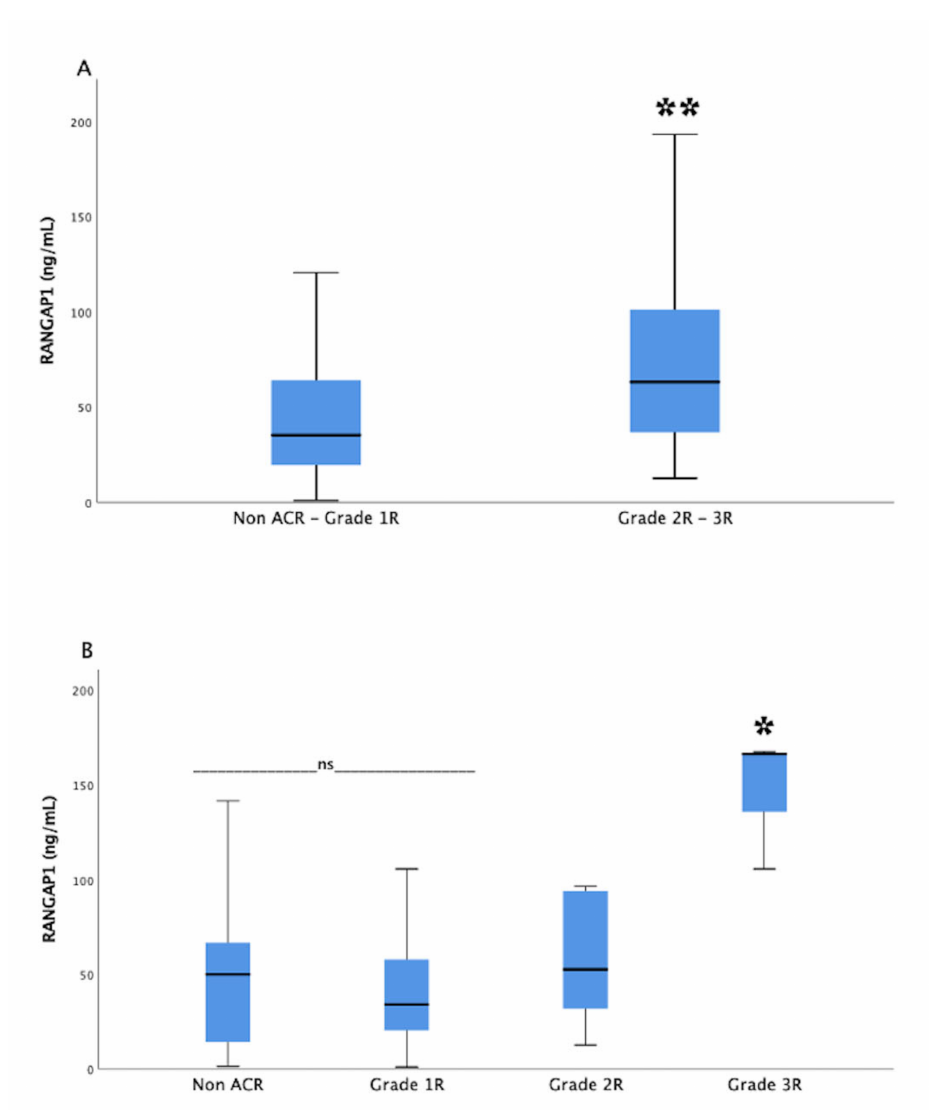
Figure 1. Circulating levels of RANGAP1 between normal and rejection heart allografts. Comparison between the serum levels of RANGAP1 in patients without and with significant acute cell rejection (ACR) ( A ). Comparison between the serum levels of RANGAP1 across different grades of rejection in heart allografts ( B ). The middle line in the box plots represents the median. The lower box represents the first quartile. The upper box represents the third quartile. Whiskers indicate the 95% confidence interval of the mean. ** p = 0.02, * p = 0.03. Grade 1R, mild rejection; grade 2R, moderate rejection; grade 3R, severe rejection; ns, no statistically significant